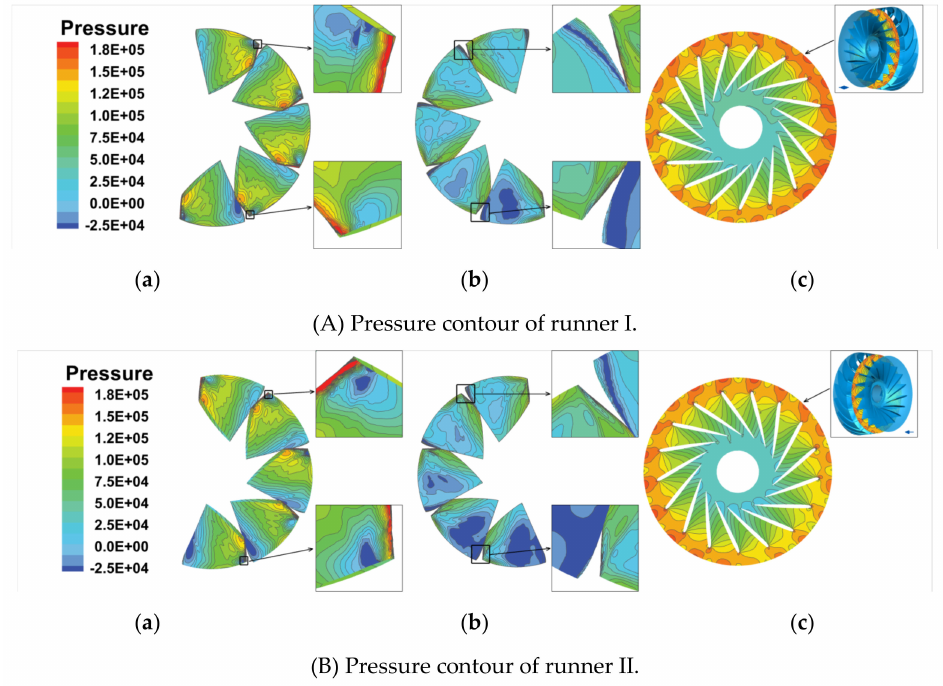
Figure 10. Pressure contour of the runner blade and runner flow channel under OLP (a 1 = 142 mm). ( a ) Pressure side of blade; ( b ) suction side of blade; ( c ) runner flow